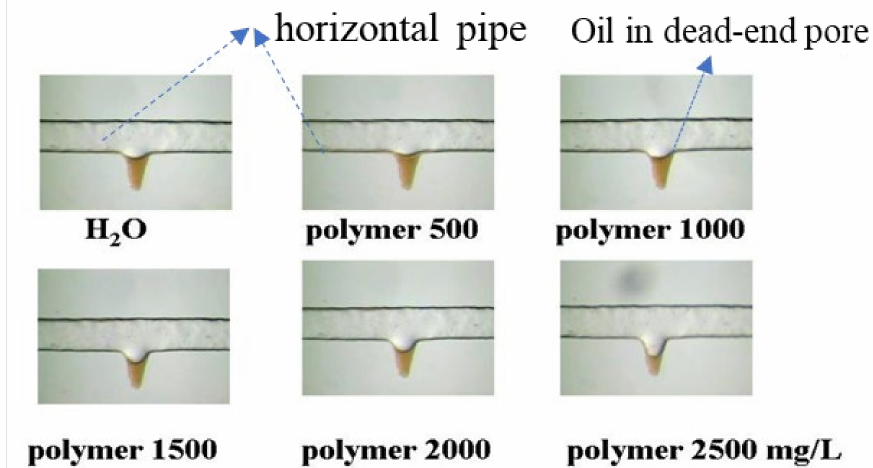
Figure 3. Dead-end oil displaced by polymer (revised from